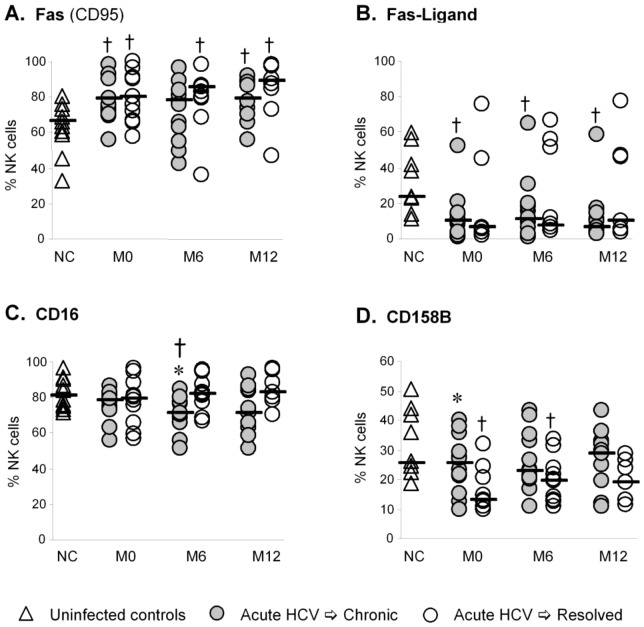
Phenotype of NK cells in acute HCV infection.Multi-parameter flow cytometric analysis was used to determine if the phenotype of NK cells was altered in acute HCV infection. Upregulation of Fas (A) and downregulation of Fas-Ligand (B) suggest activation of NK cells in acute HCV infection. Fas remains upregulated even after viral clearance. The decrease observed for NK CD16 expression in the chronically evolving patient group at month 6 (C) is consistent with altered NK subset distribution. Decreased expression of the inhibitory KIR CD158B (D) in the spontaneously resolving group at baseline suggests a genetic contribution to the outcome of acute HCV infection. * p<0.05 chronic versus resolved; † p<0.05 versus uninfected control (MWU) Abbreviations: NC = normal control; M = month.